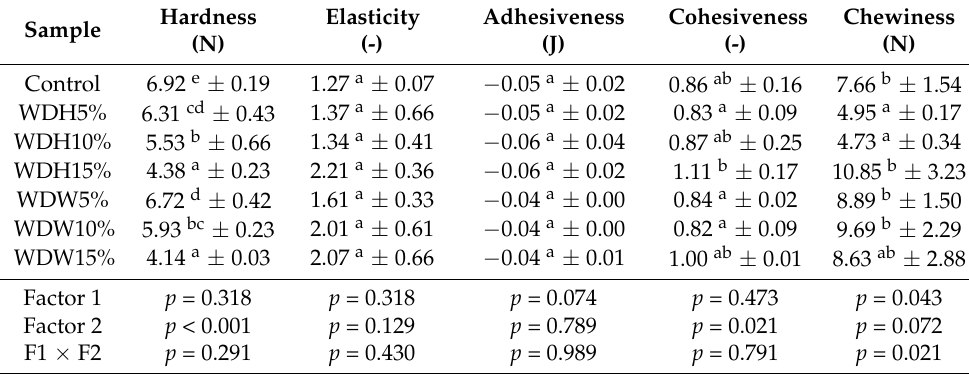
Table 6. Textural properties of the tested